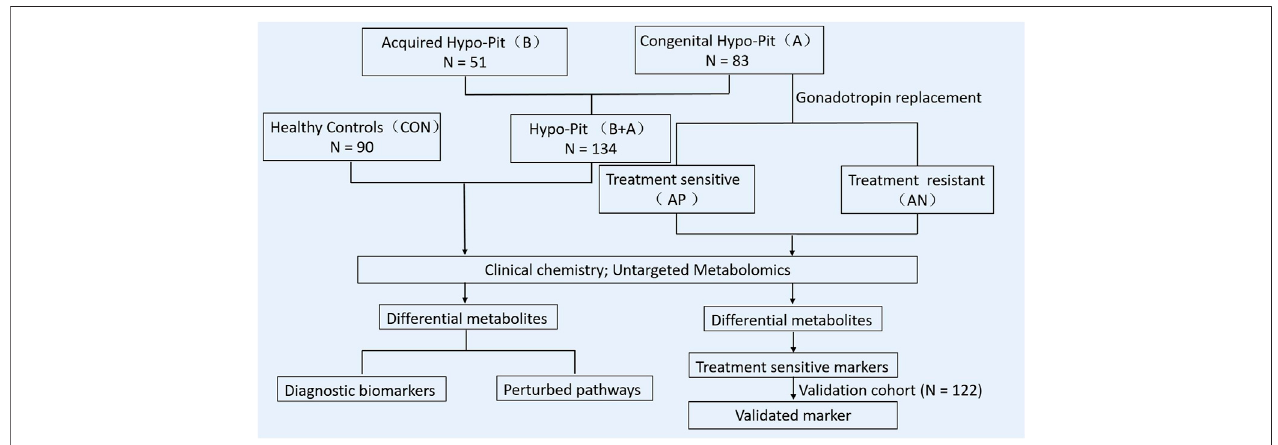
FIGURE 1 | Flowchart of the study design in this